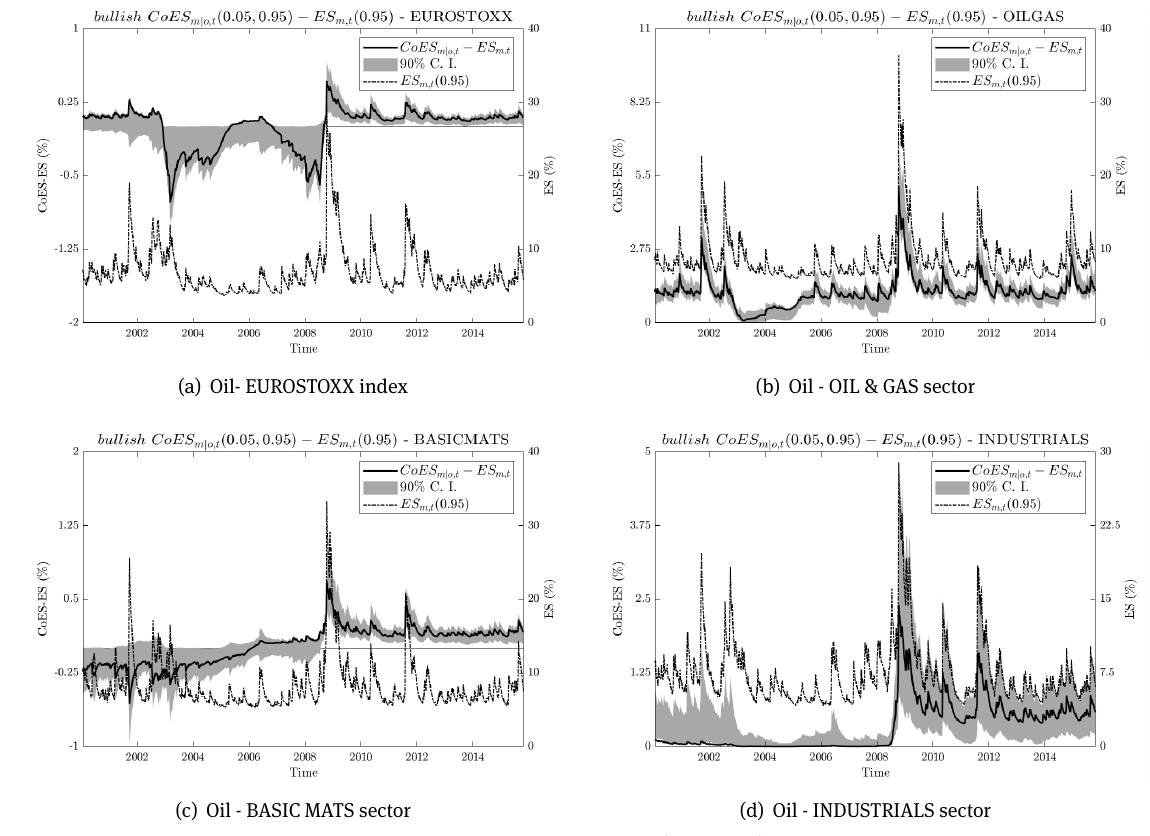
Figure 21a: CoES m | o , t (0.05, 0.95) for a certain sector given a bearish scenario for oil prices